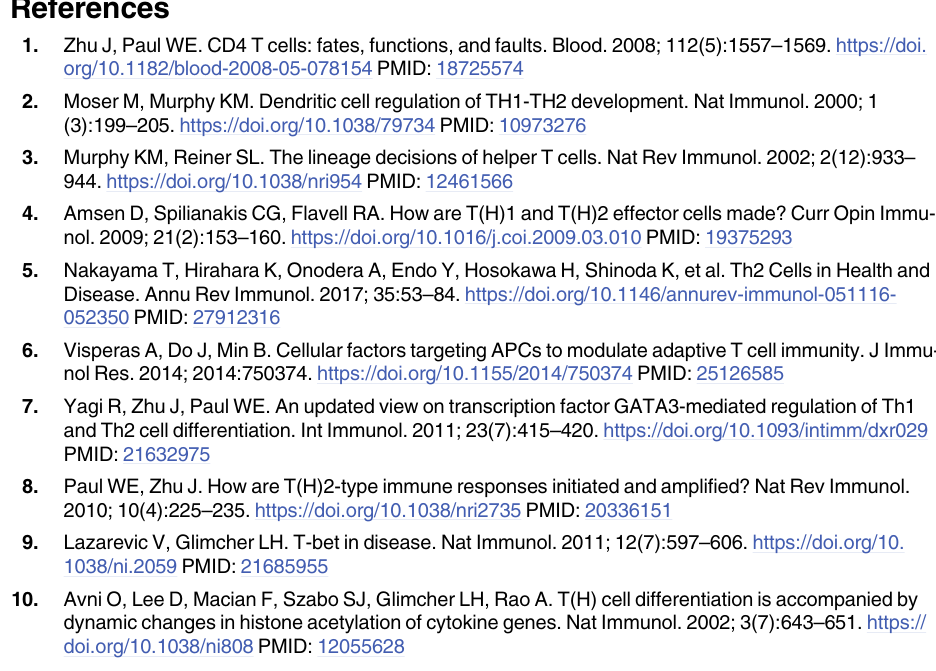
S1 Table. Primer sequence and probes for quantitative